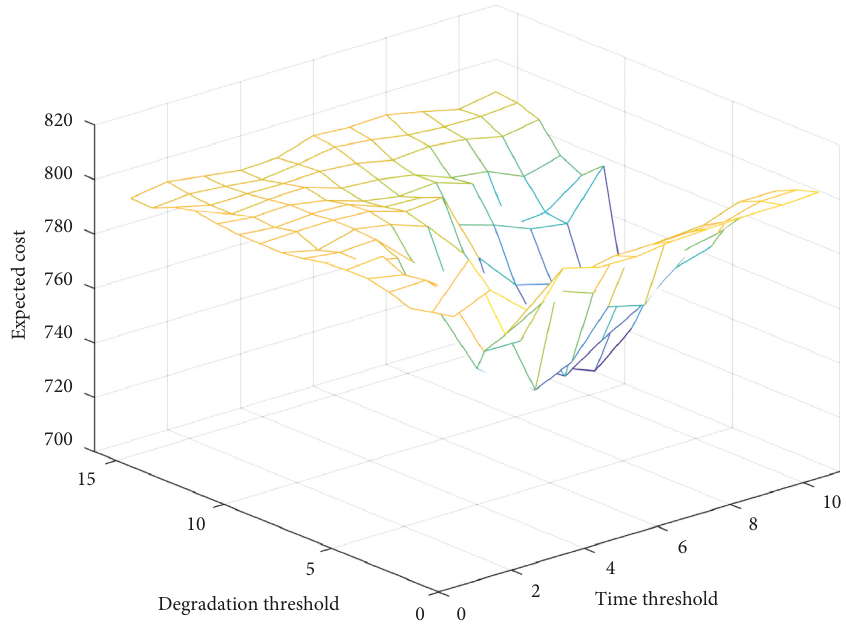
Figure 2: Expected cost under single attempt. Table 1: Optimal abandon thresholds under task success criteria I given different allowable time and task duration.